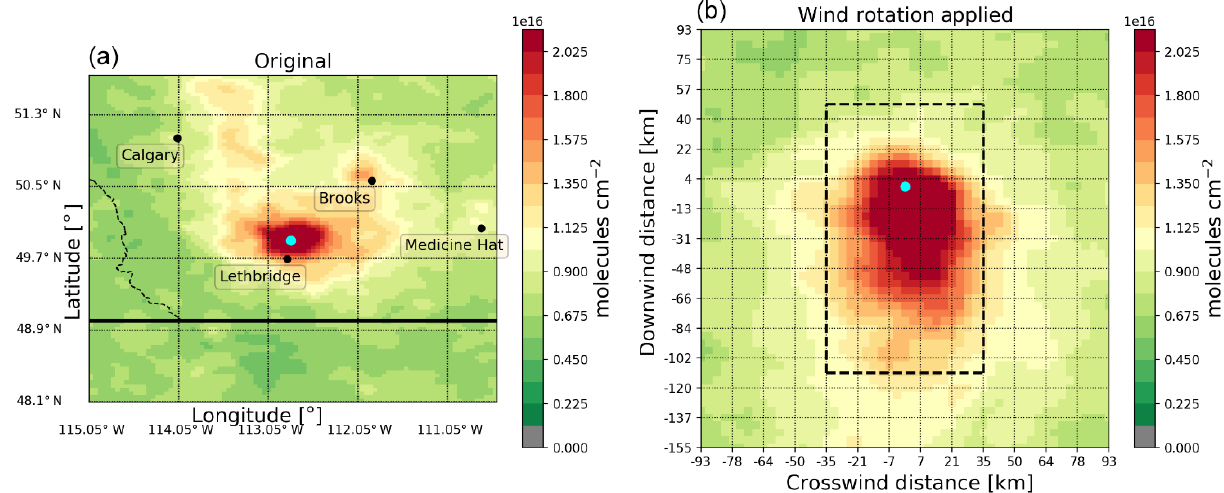
Figure 15. Plot of the CrIS NH 3 total column observations from the 5-year (2013–2017) period over Lethbridge, Alberta, Canada. The (a) plot shows the distribution of NH 3 for the surrounding region. The black dots indicate nearby population centres for easy reference. The (b) plot shows the same set of observations for a smaller region centred on Lethbridge but now redistributed by wind direction showing the upwind and downwind total columns. The blue circle shows the location of the reference point used in the wind rotation and corresponds to the geographic centre of emissions.